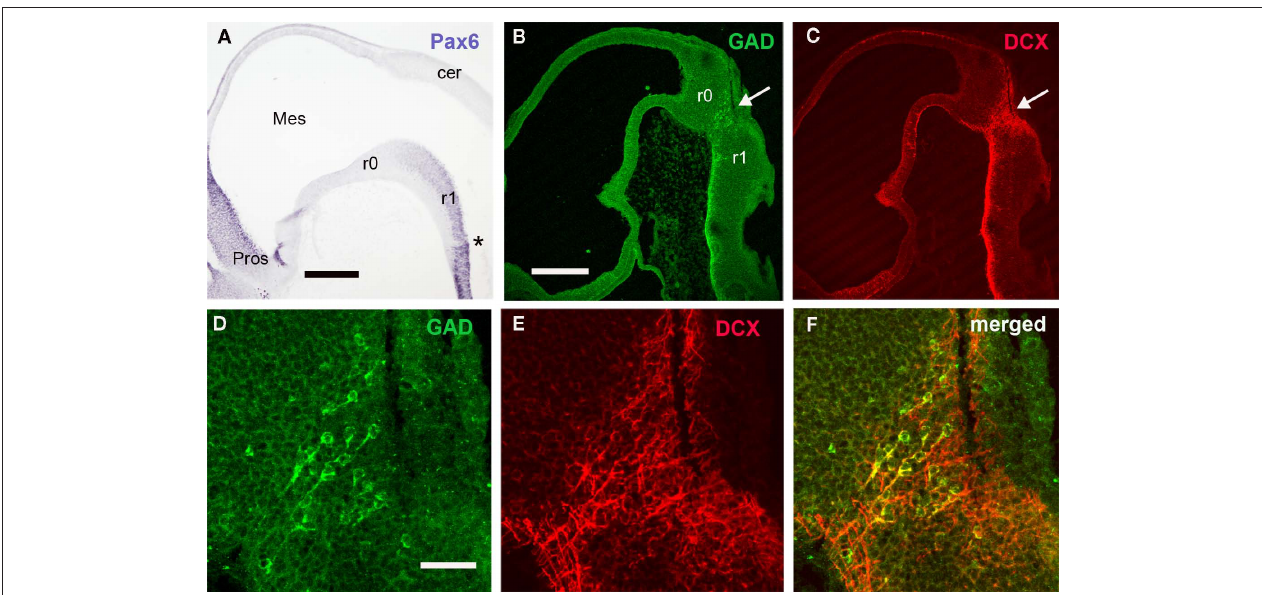
Figure 3 | The distribution of Pax6, gAD, and DCX cells reveals the r0/r1 boundary. (A–C) Panoramic views of sagittal sections of embryos at stage 26 to show the distribution of Pax6 (A) , GAD (B) , and DCX (C) in the rostral rhombencephalon. Note the absence of Pax6 cells in r0 and the dorsoventral